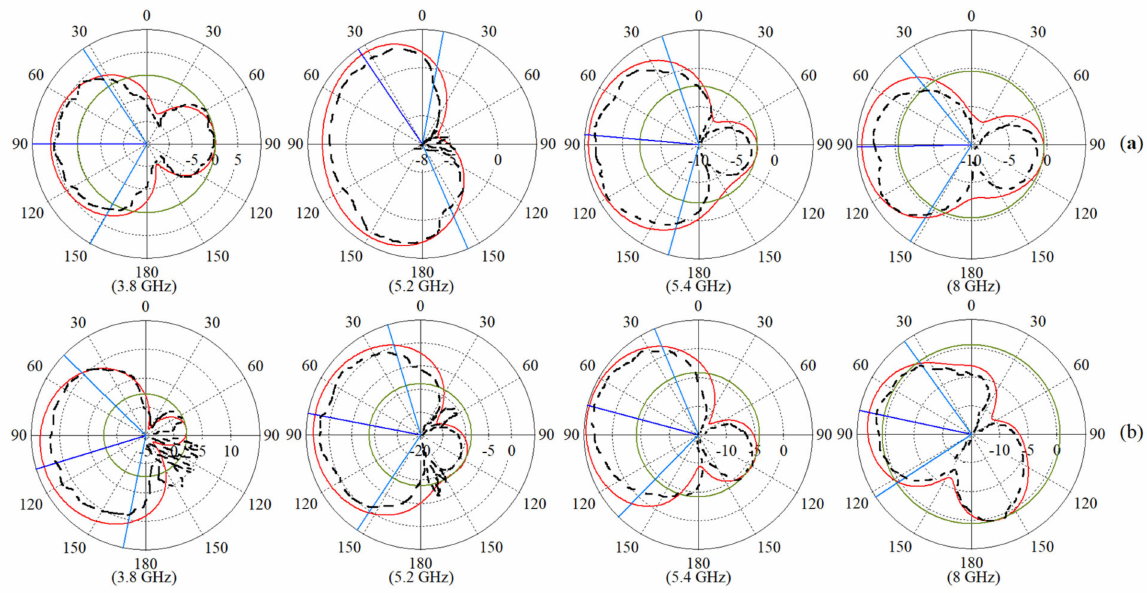
Figure 16. The 2D radiation patterns of the antenna for: ( a ) Ant 1, ( b ) Ant 2 (red line: simulated co-polarization, black dashed line: measured co-polarization, on the xz